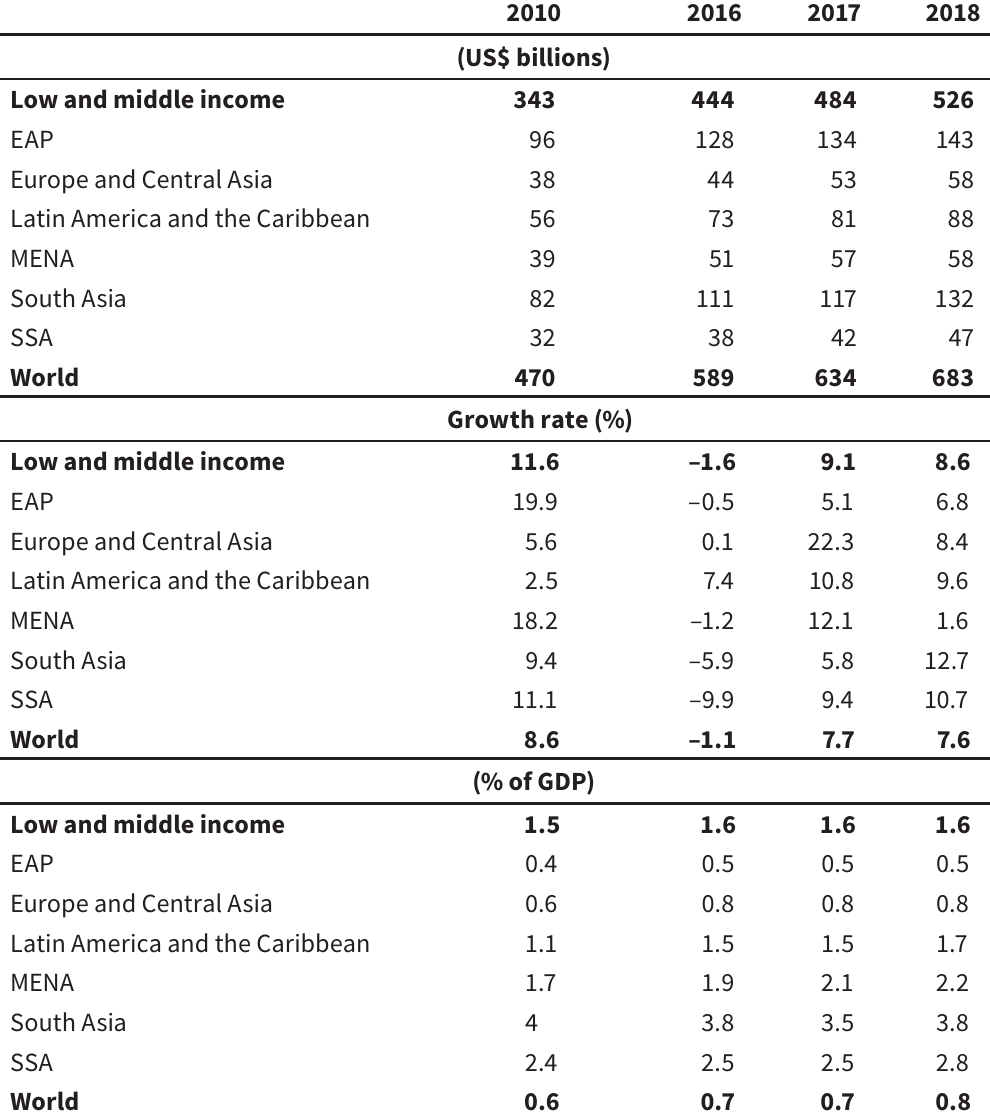
Table 2 Remittance inflows to low- and middle-income